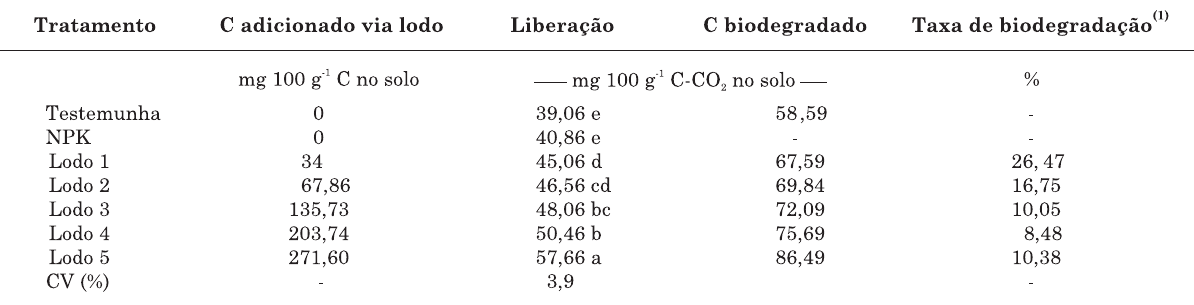
Figura 4. Liberação acumulada de CO acrescido de lodo anaeróbio da estação de tratamento de efluentes da parboilização do arroz, durante 50 dias de incubação. * Significativo a 5 %. (1) Tratamento NPK incluído como referência fora da análise de